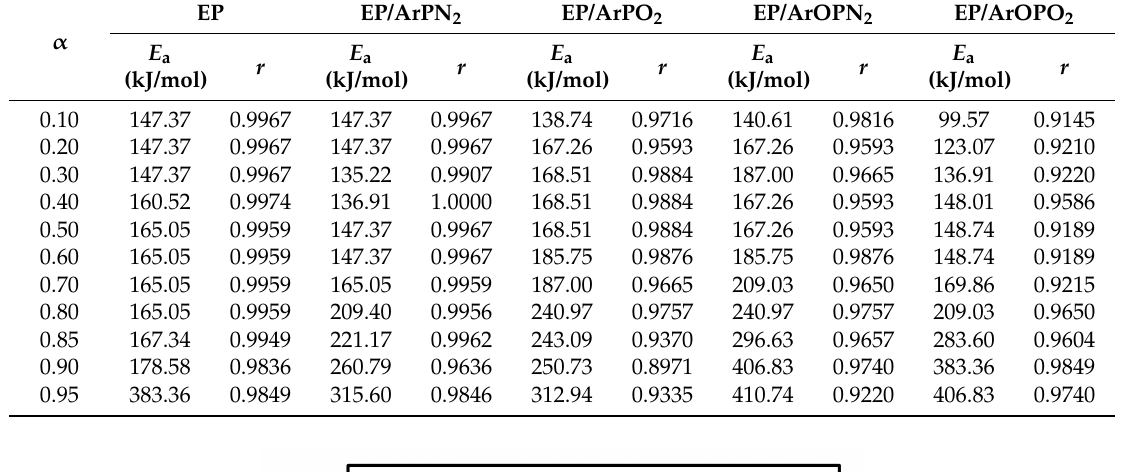
Table 5. Calculated E a at various conversions using the FWO method for EP/polysulfone composites.